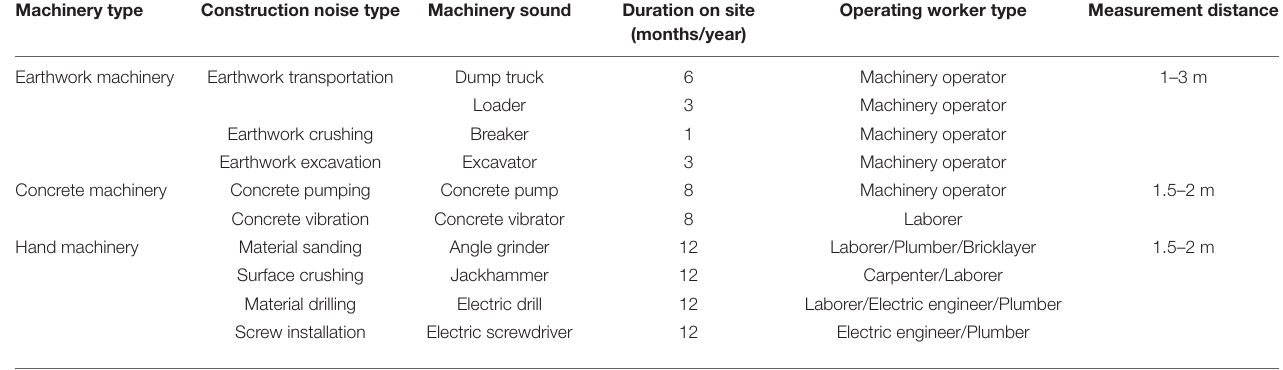
TABLE 2 | Questionnaire composition.